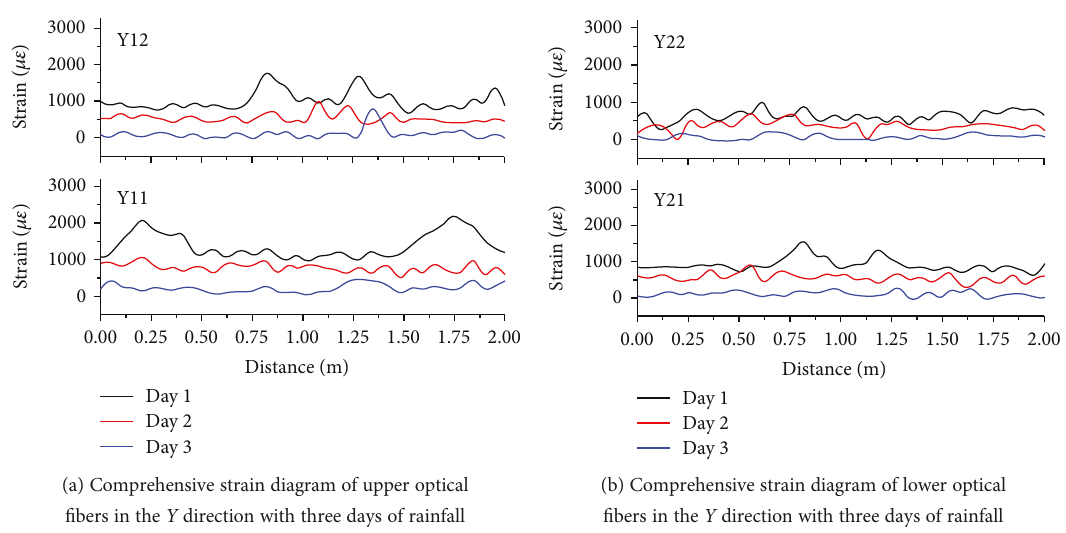
Figure 13: Comprehensive strain diagram of optical fi bers in the Y direction with three days of